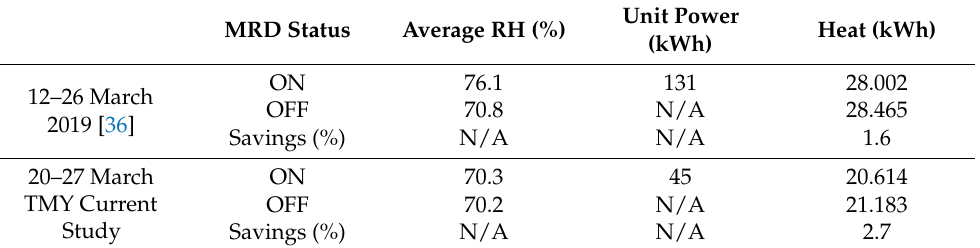
Table 12. Comparison between experimental data and simulation results for HRV spring test